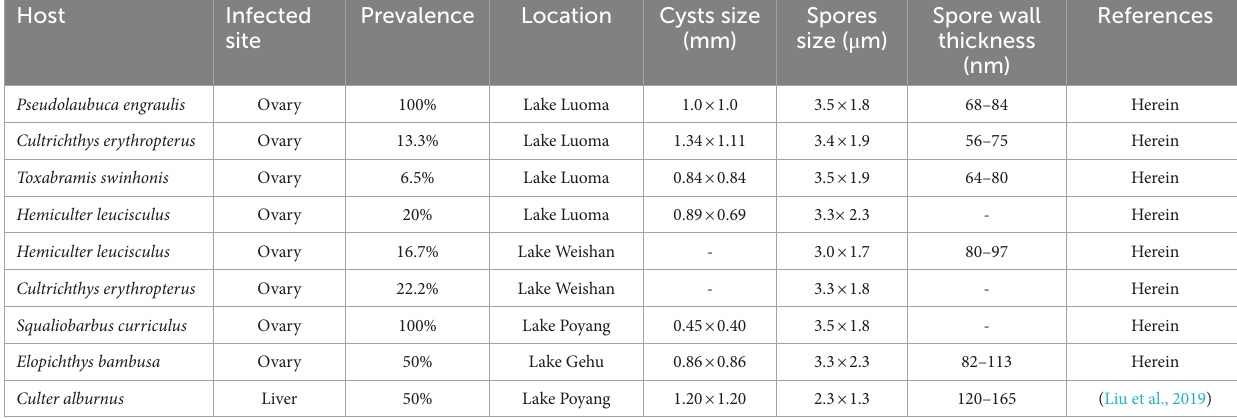
TABLE 2 Morphological comparison of different Pseudokabatana alburnus